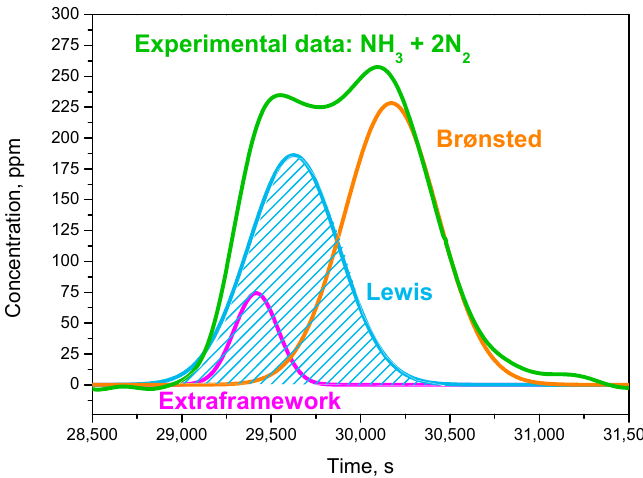
Figure 2. Deconvolution of the NH3-TPD profile over 1.7Cu-CHA 25 catalyst in Figure 1B.